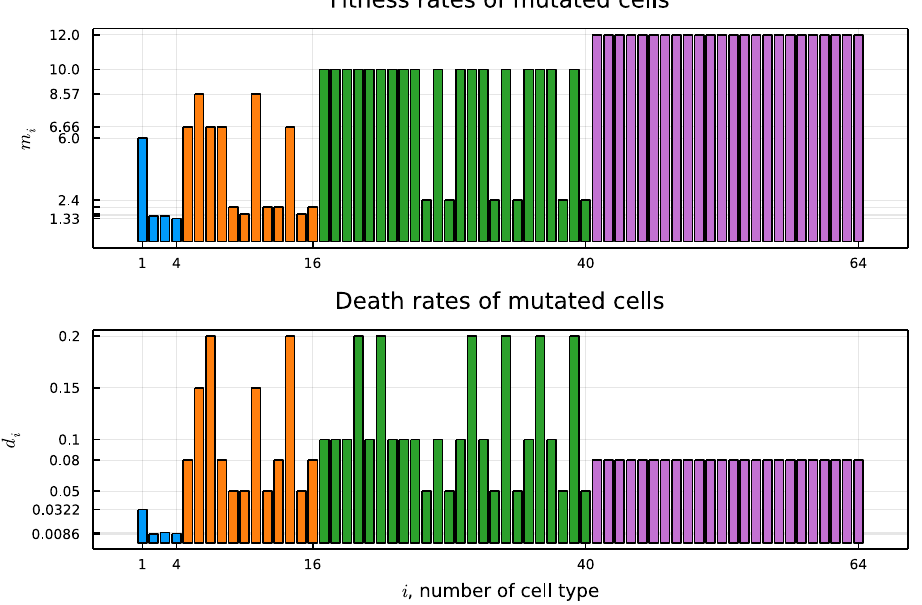
Figure 2. Fitness rates m i and death rates d i of mutated cells. Colors correspond to one-letter (blue), two-letter (orange), three-letter (green), and four-letter (magenta)